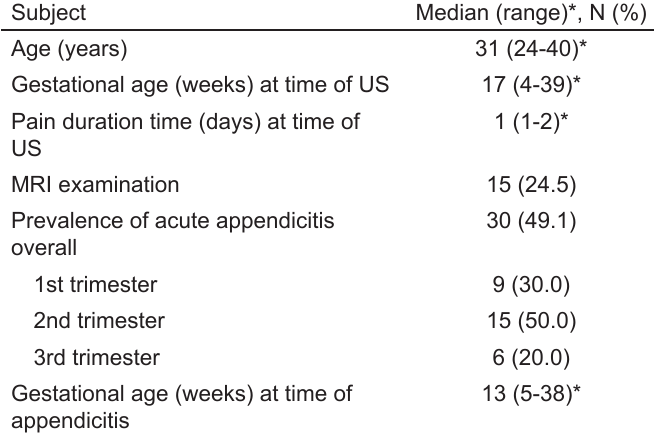
Table 1. Patients` characteristics.